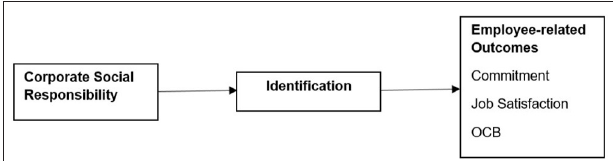
FIGURE 2 | Overview of meta-analytical mediation